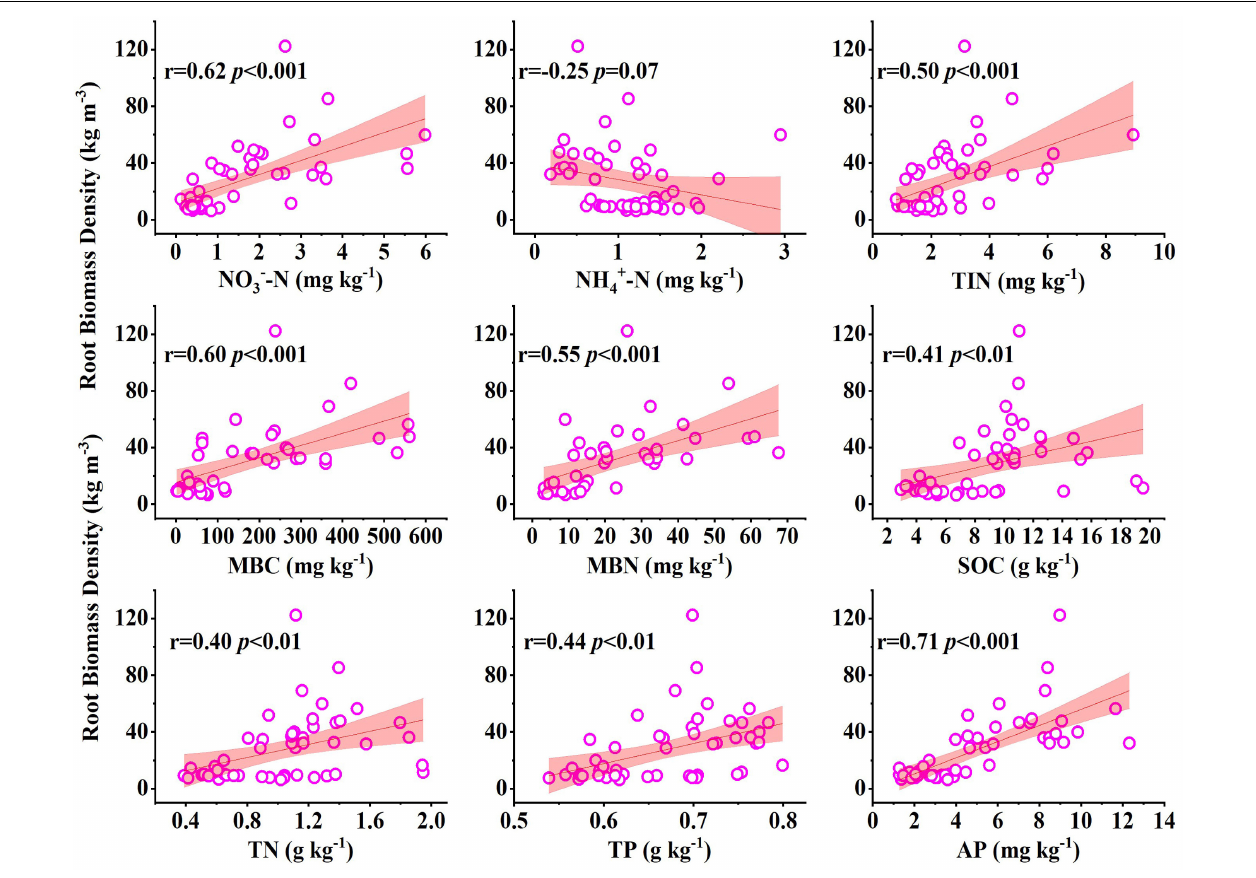
FIGURE 4 | Relationships of root biomass density with soil properties (data were collected in 2019, 17 years after revegetation). NO 3 - -N, nitrate nitrogen; NH 4 + -N, ammonium nitrogen; TIN, total inorganic nitrogen; MBC, microbial biomass carbon; MBN, microbial biomass nitrogen; SOC, soil organic carbon; TN, total nitrogen; TP, total phosphorus; AP, available